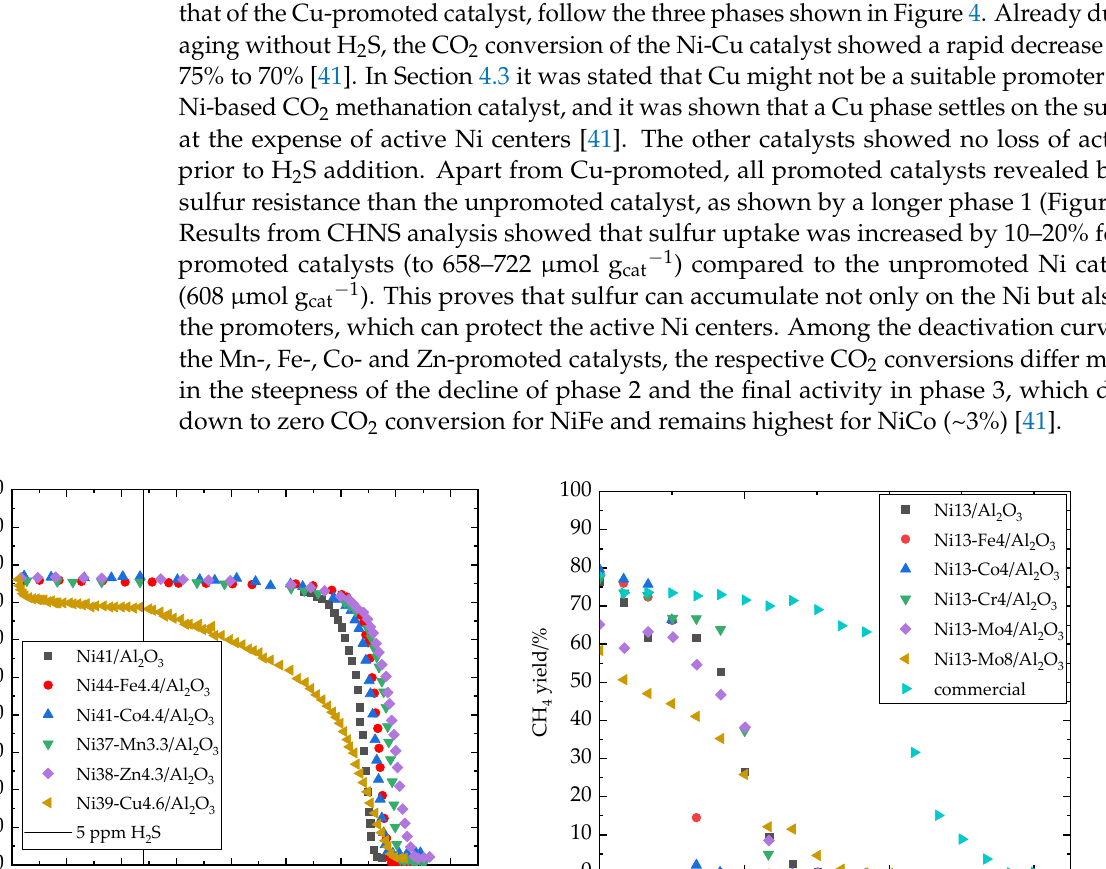
Table 17. Catalysts and reaction conditions for experiments on H 2 S influence with Ni/Al 2 O 3 and Co, Cr, Fe, and Mo as promoter [64].